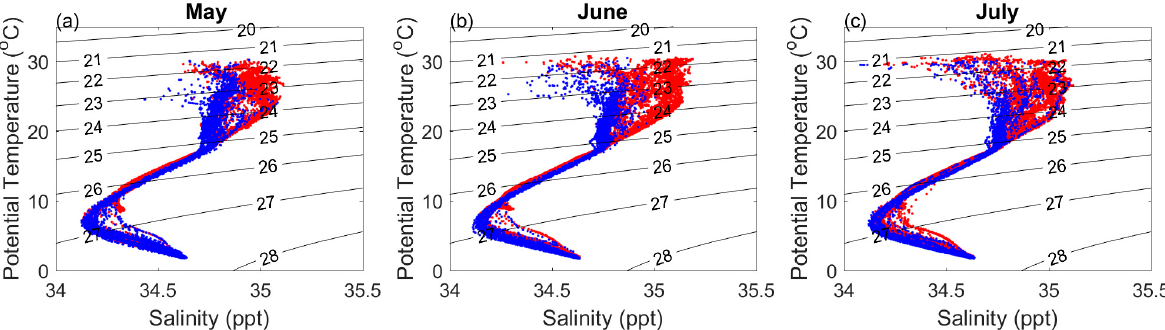
Figure 8. Temperature–salinity (TS) diagrams in ( a ) May, ( b ) June, and ( c ) July, obtained from the Argo floats with their locations shown in Figure 1b. Blue and red dots show the TS properties corresponding to the absolute dynamic topography (ADT) smaller and larger than 1.45 m (north and south of subtropical front), respectively. Black contours show the potential density.